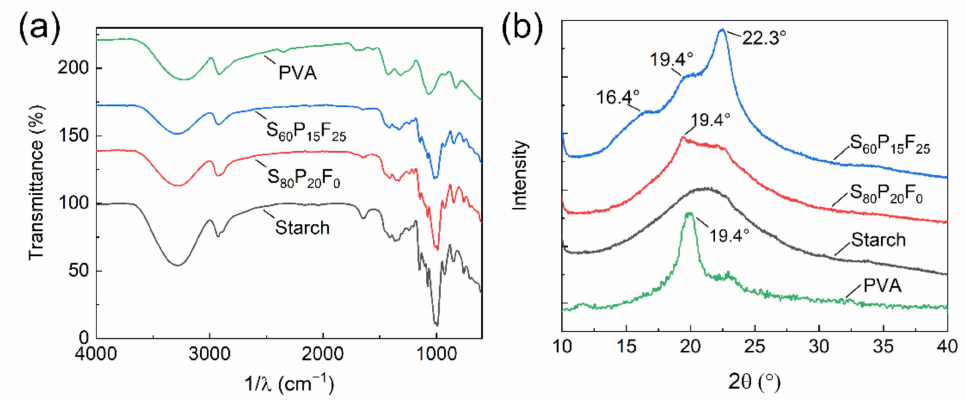
Figure 3. ( a ) FT-IR and ( b ) XRD pattern of different SPF